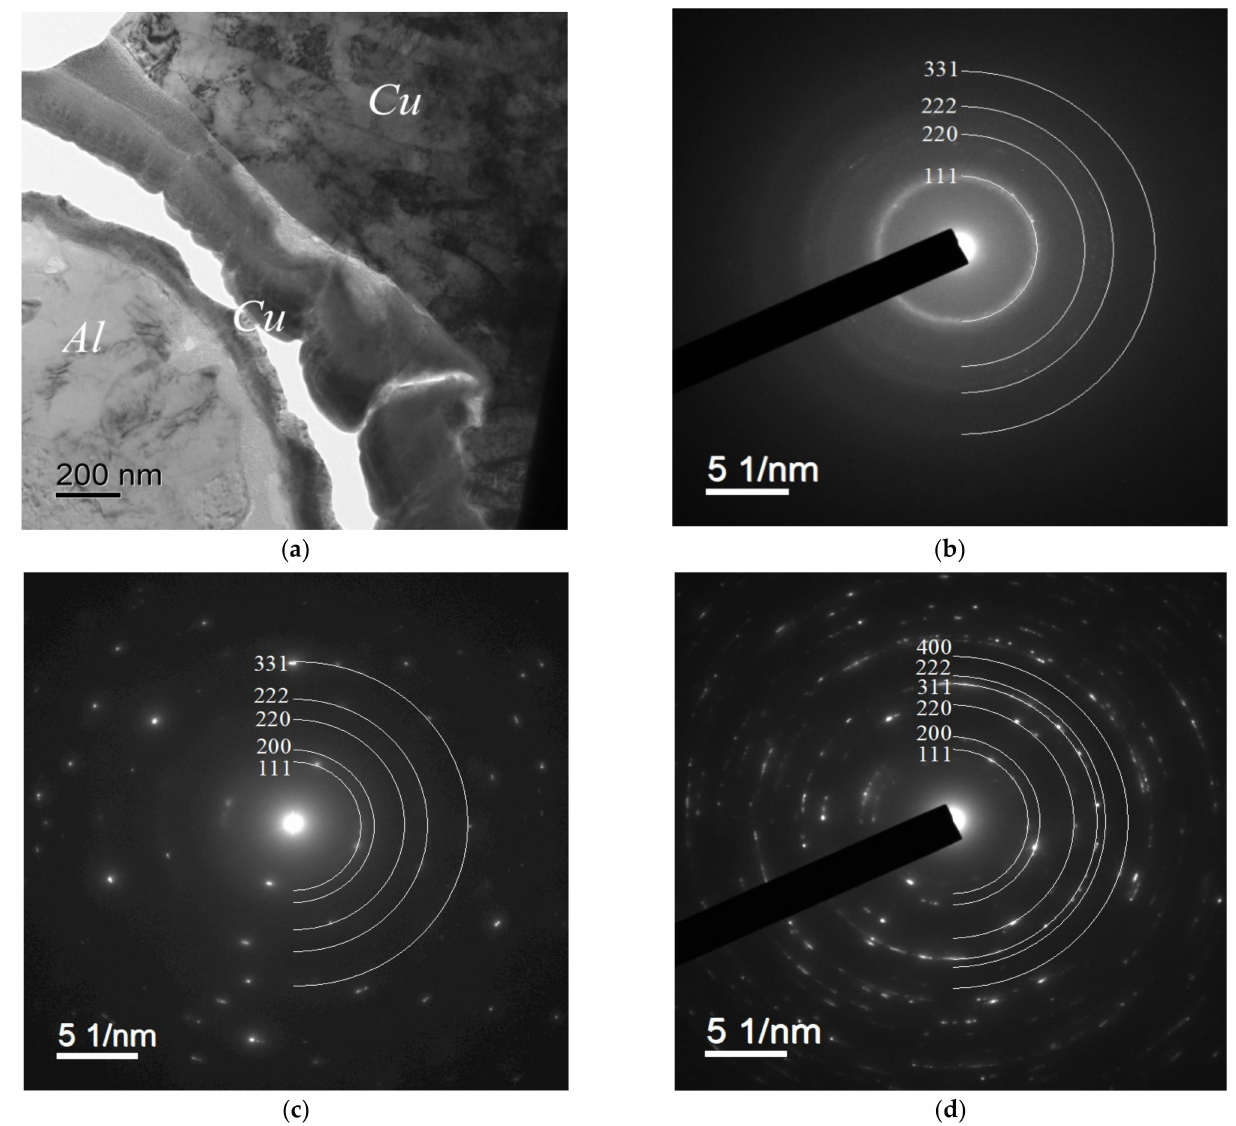
Figure 6. The results of TEM investigations of the interphase boundary “Al wire–Cu” in the initial state after rolling. Alloy #2: ( a ) general view of the investigated area (a crack formed that along the Al-Cu interphase boundary in the course of preparation of a thin foil for electron microscopy investigations is visible in Figure 6a. The presence of such cracks is an artifact of sample preparation. No interphase boundary destruction was found when investigating the polished samples by